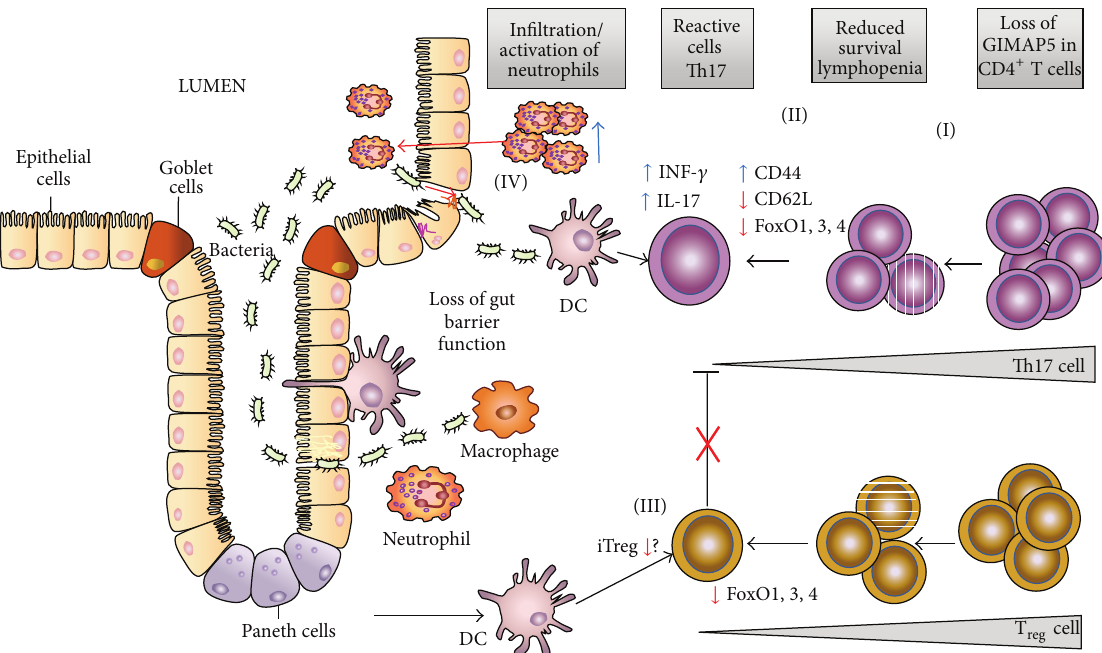
Figure 2: Schematic representation of the key events causing colitis in Gimap5 -deficient mice. Loss of Gimap5 leads to reduced survival of lymphocytes (I) including CD4 + T cells with remaining T cells exhibiting a characteristic LIP phenotype ( CD 44 high ; CD 62 L low ) and polarization towards Th17 (II). Importantly, during the onset of CD4 + T cell lymphopenia, a progressive loss of full-length FoxO1, FoxO3, induction (iTreg) and function in the gut tissue (III). The lack of T and FoxO4 expression is observed that correlates with a loss of T reg reg immunosuppressive activity (indicatedby the red X) triggers activation of CD4 + Th1/Th17 cells in the gut causing production of IL17 and IFN 𝛾 cytokines and subsequent infiltration of macrophages/neutrophils that further amplify intestinal inflammation and a loss of epithelial barrier function (IV) and may ultimately lead to neutrophil transepithelial migration (for an extensive review on neutrophils in IBD pathogenesis, see